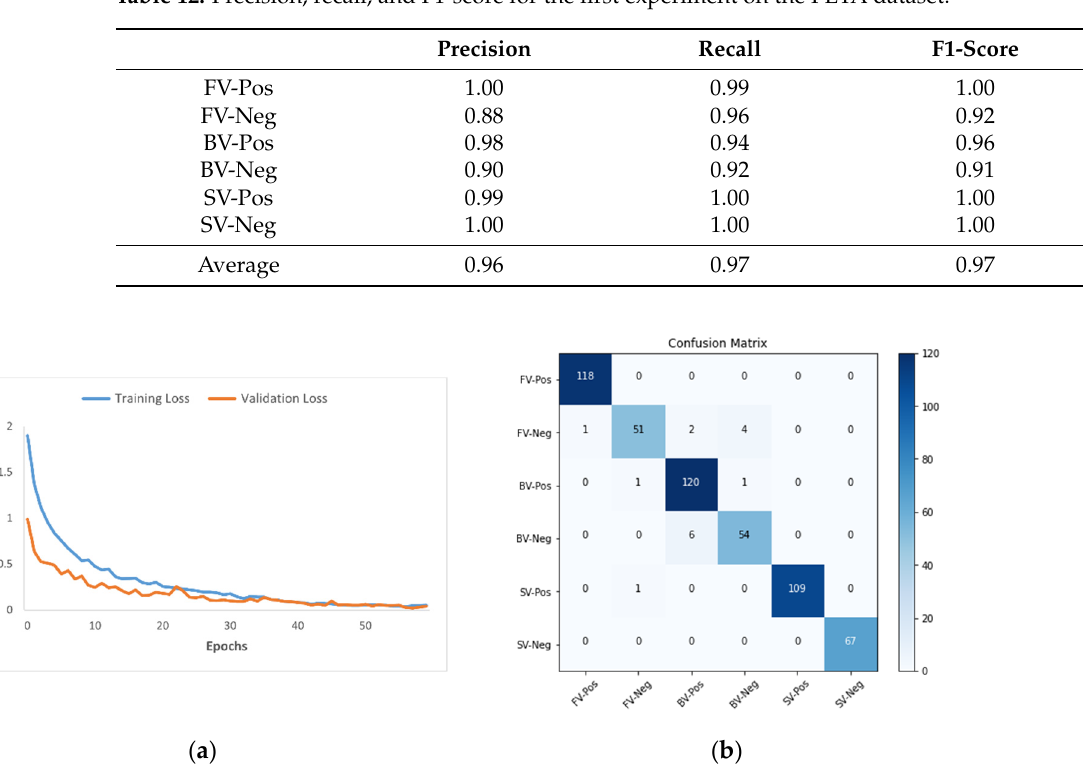
Table 10. PETA dataset distribution for multi-classification for the first experiment.